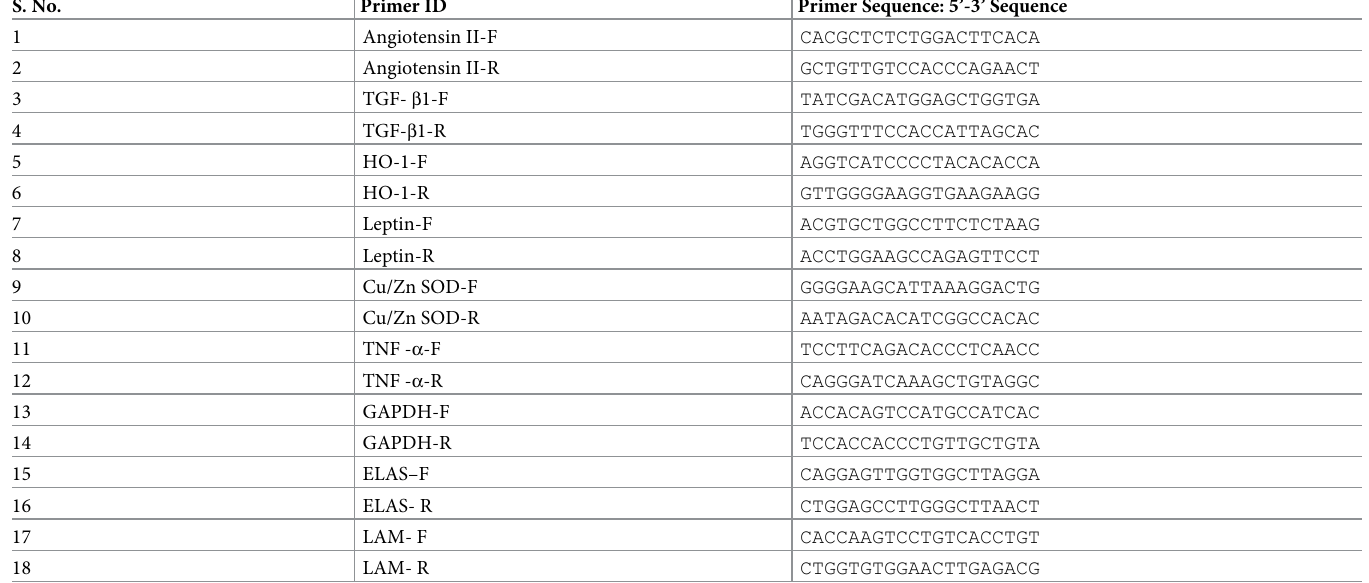
Table 2. List of primers for the selected